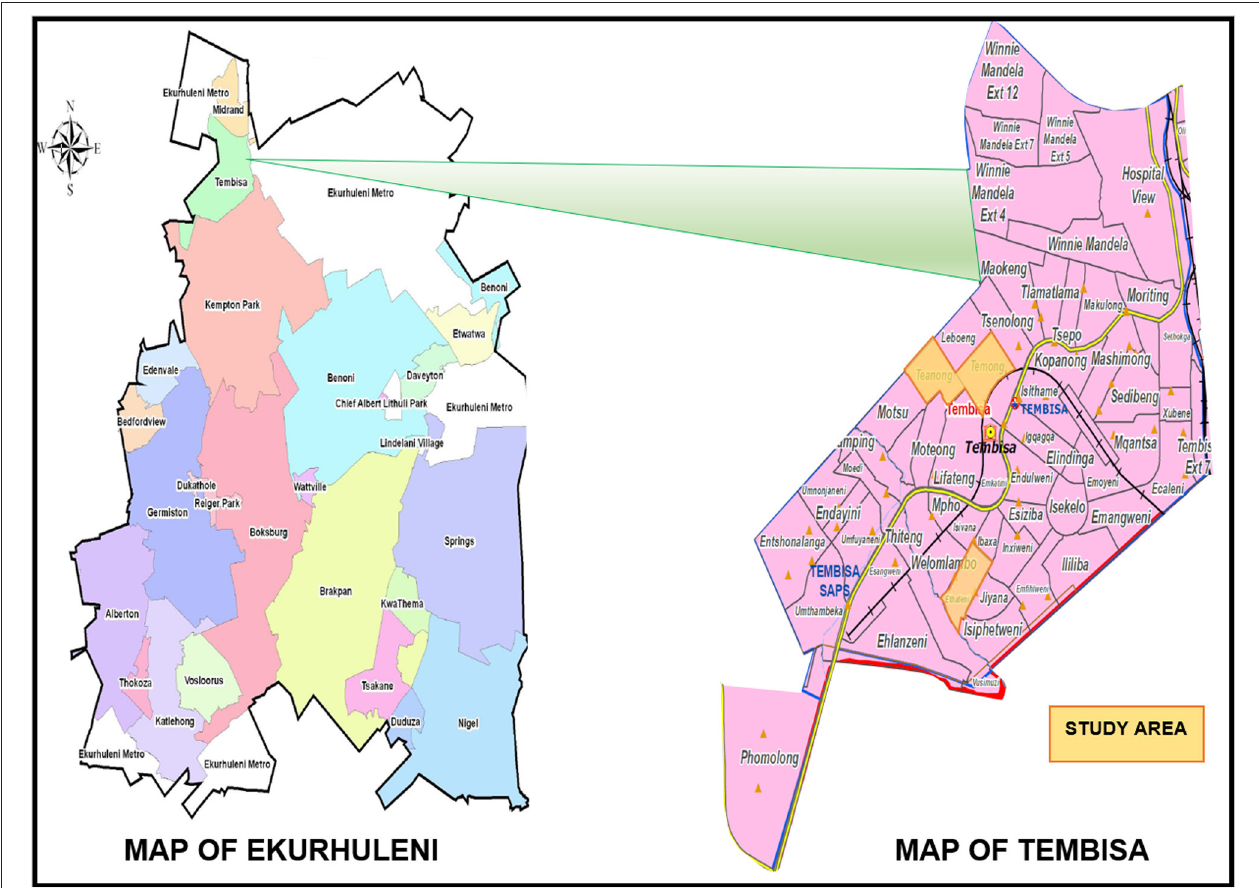
FIGURE 1 | The location of Tembisa situated in the East of Gauteng, in Ekurhuleni Metropolitan Municipality, indicated by the area shaded in red. With the study areas (Teanong, Temong, and Ethafeni) in Tembisa shaded in